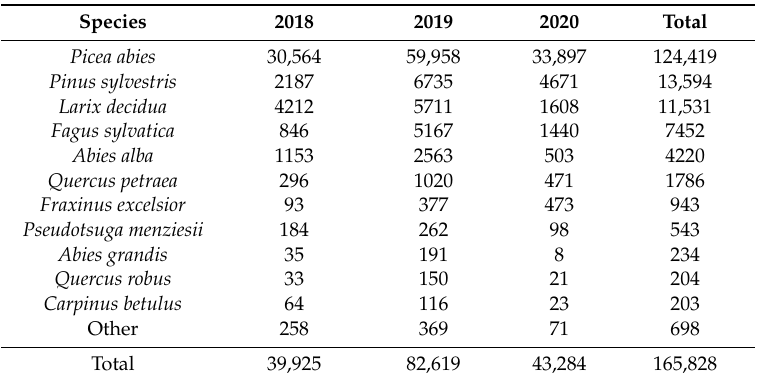
Figure 3. Progress of the volume of timber harvesting in millions of cubic meters, divided into coniferous and deciduous timber. Source: Ministry of Agriculture of the Czech Republic, 2020 [31]. Table 1. Summary of salvage cutting volumes (m 3 ) per species and year (until 15 July 2020) at the University Forest Enterprise (UFE)